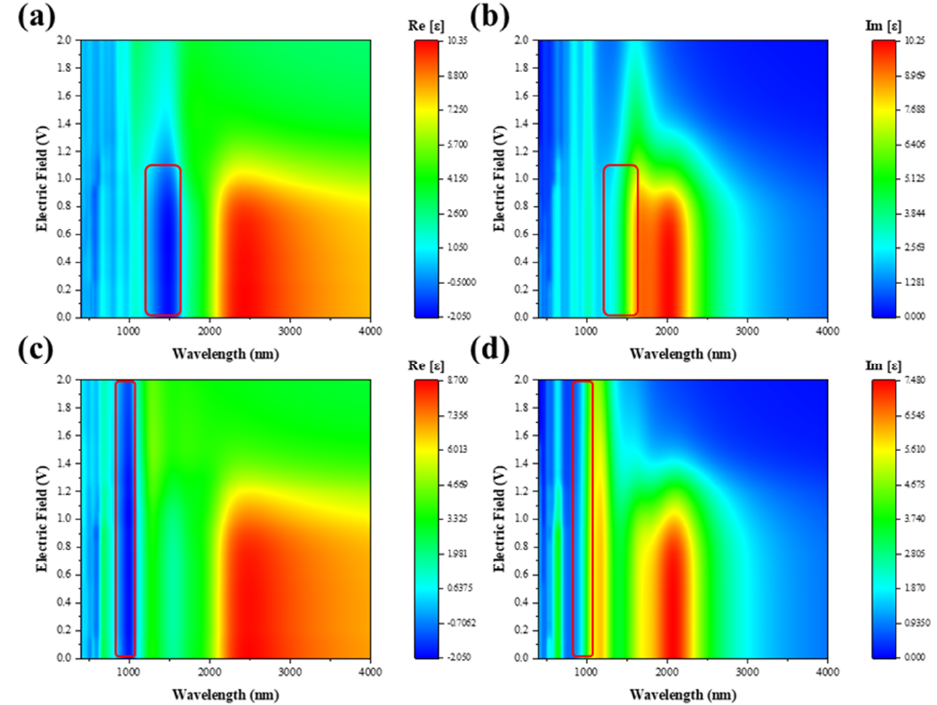
Figure 5. Color map of the plasmon spectrum of TBG induced by external electric field at 350 − 4000 nm. The ( a , c ) and ( b , d ) are the real and imaginary part of dielectric function in x and y orientation, respectively. The region in the red box will excite the surface plasmon due to the negative real part.